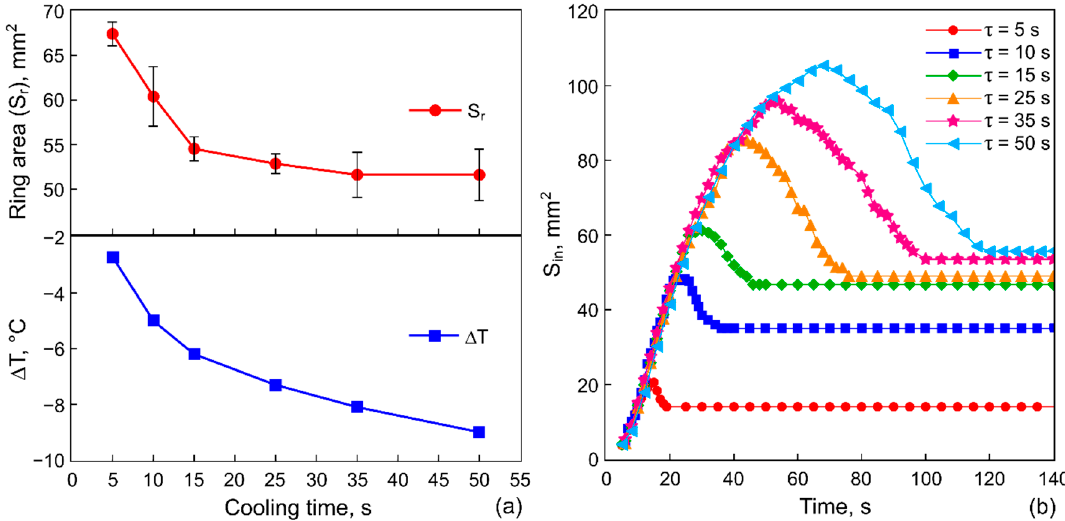
Figure 5. ( a ) The ring-deposit area and the temperature decreasing on the heat sink. ( b ) The evolution of the inner area (the area cleaned from particles) forming at different cooling time spans 5, 10, 15, 25, 35 and 50 s.